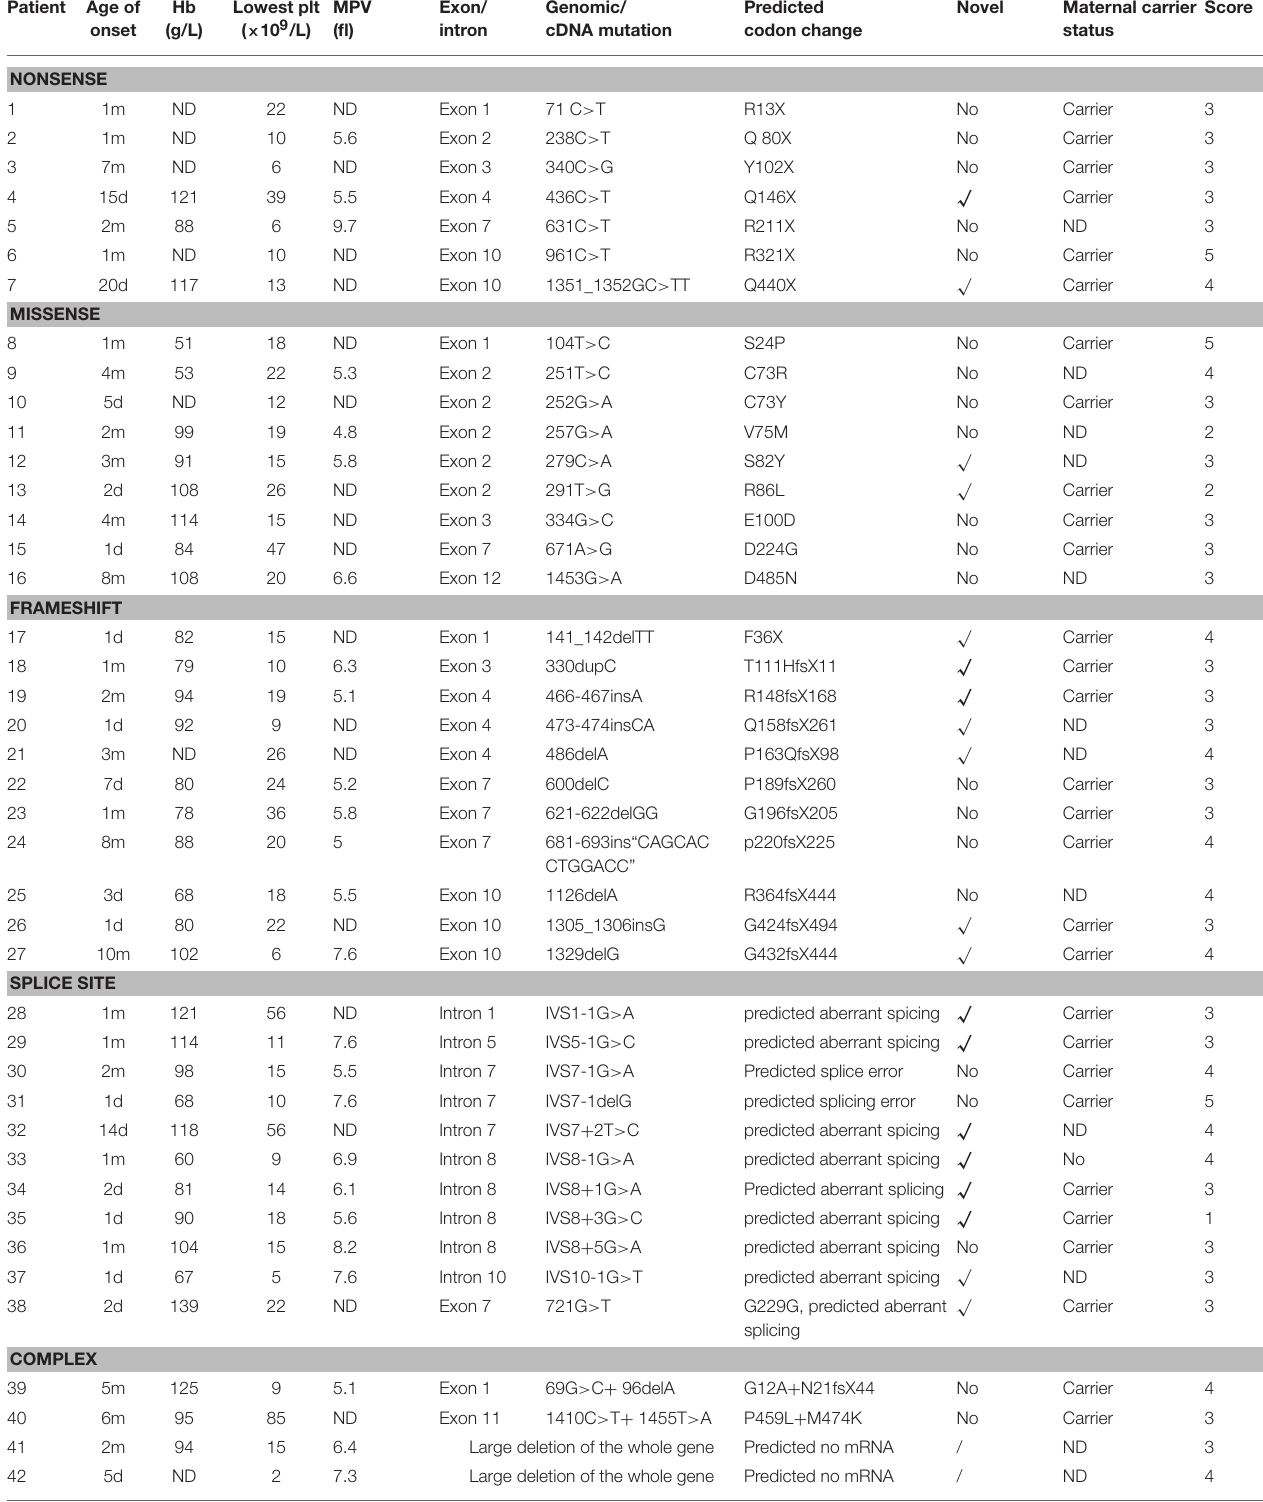
TABLE 2 | Mutation type of 42 cases of WAS and other related data. Patient Age of onset